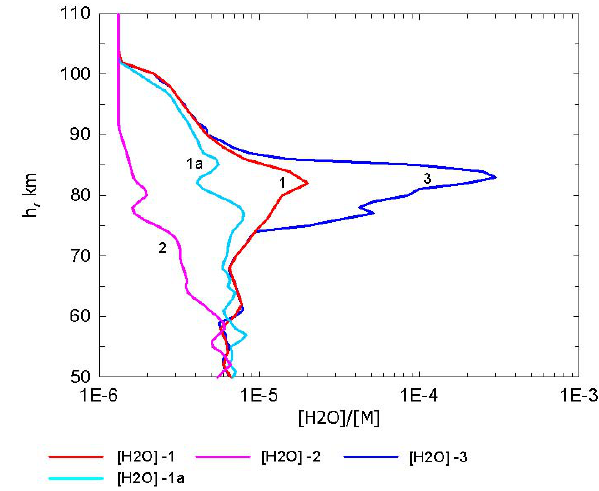
Fig. 2. Water vapour profiles in ppmv in the mesosphere used as in- put parameters for calculations. Experimental profiles H 2 O-1, H 2 O- 1a, and H 2 O-2 were retrieved from the HALOE measurements on 19 June 2004 (H 2 O-1), 4 June 2005 (H 2 O-1a) and 25 January 2004 (H 2 O-2).